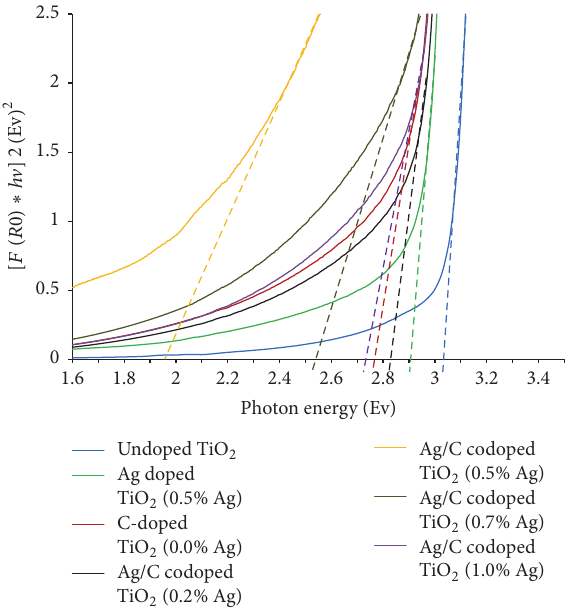
Figure 6: Tauc plots of undoped TiO 2 , Ag doped TiO 2 , and Ag/C codoped TiO 2 photocatalysts with different contents of